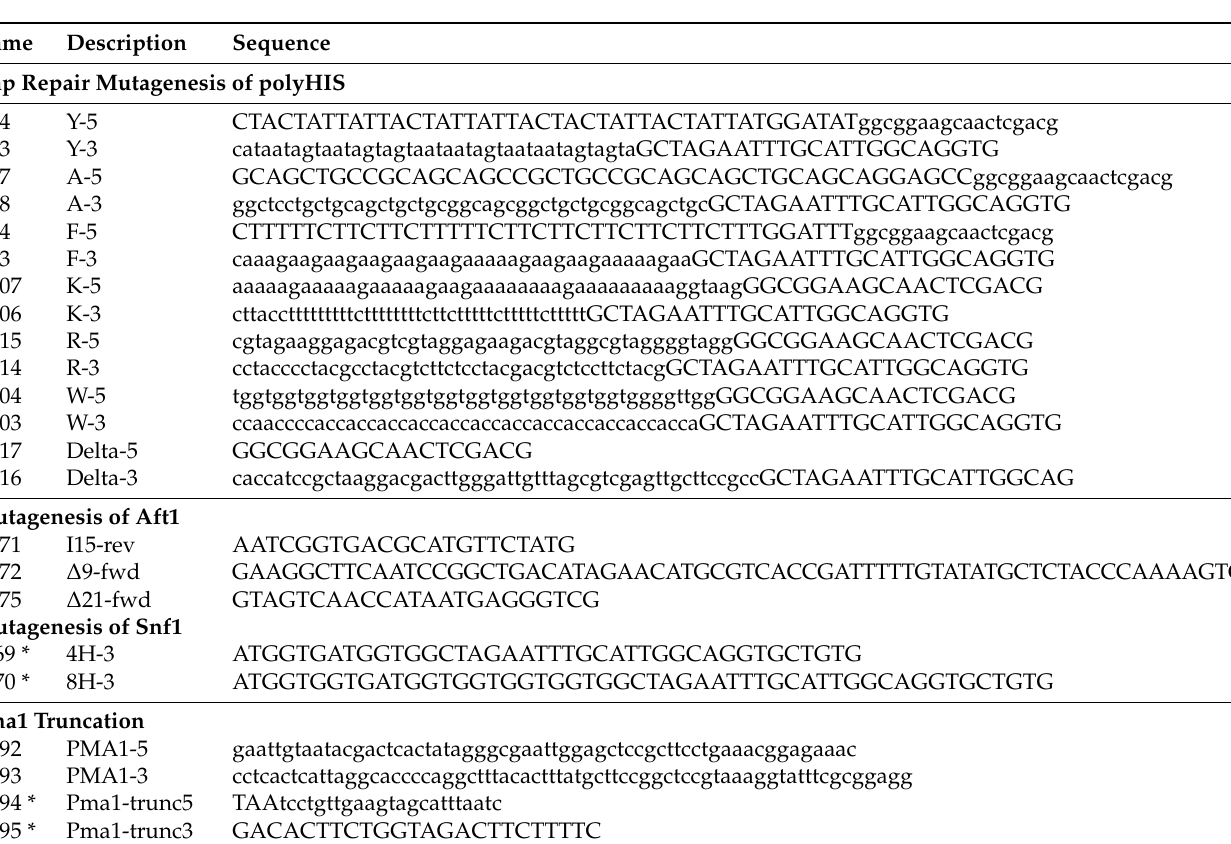
Table 3. Oligonucleotides for Mutagenesis of